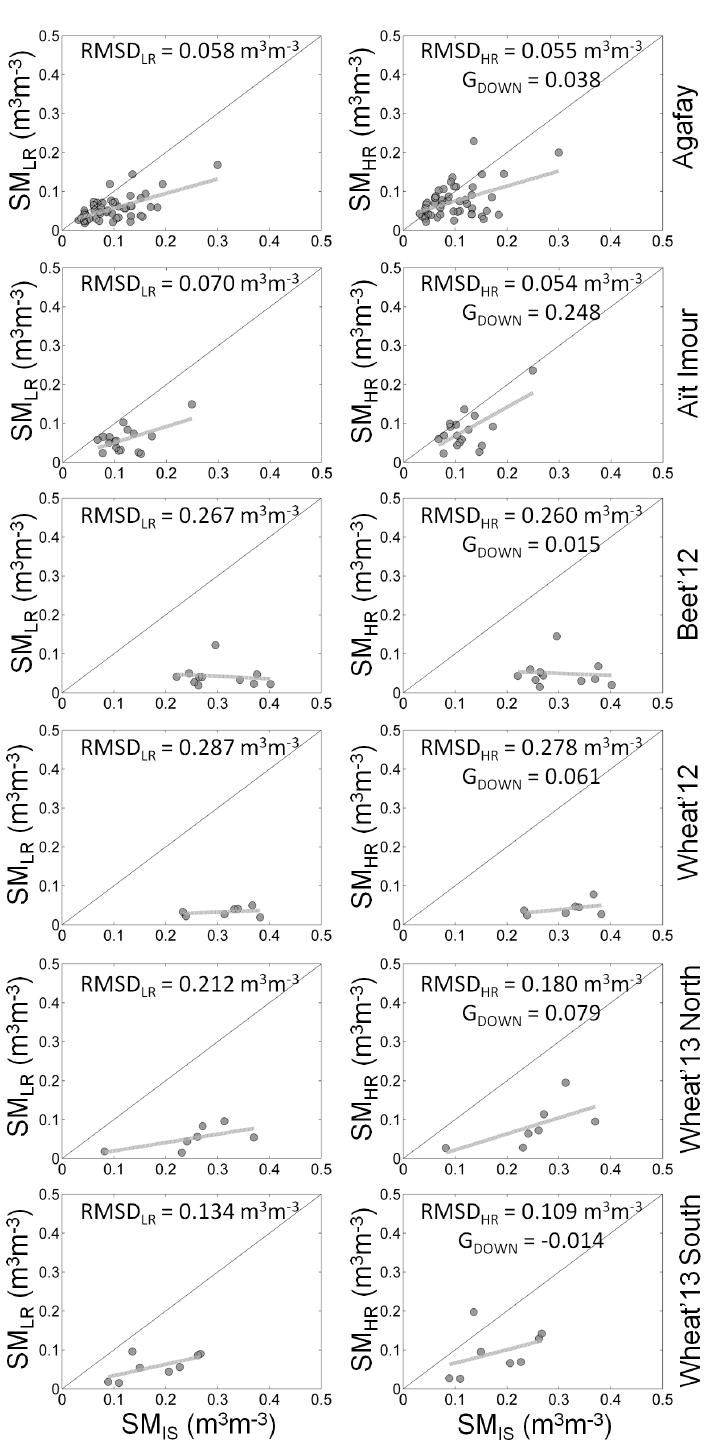
Figure 6. Same as in Figure 5, but for a DISPATCH count threshold set to